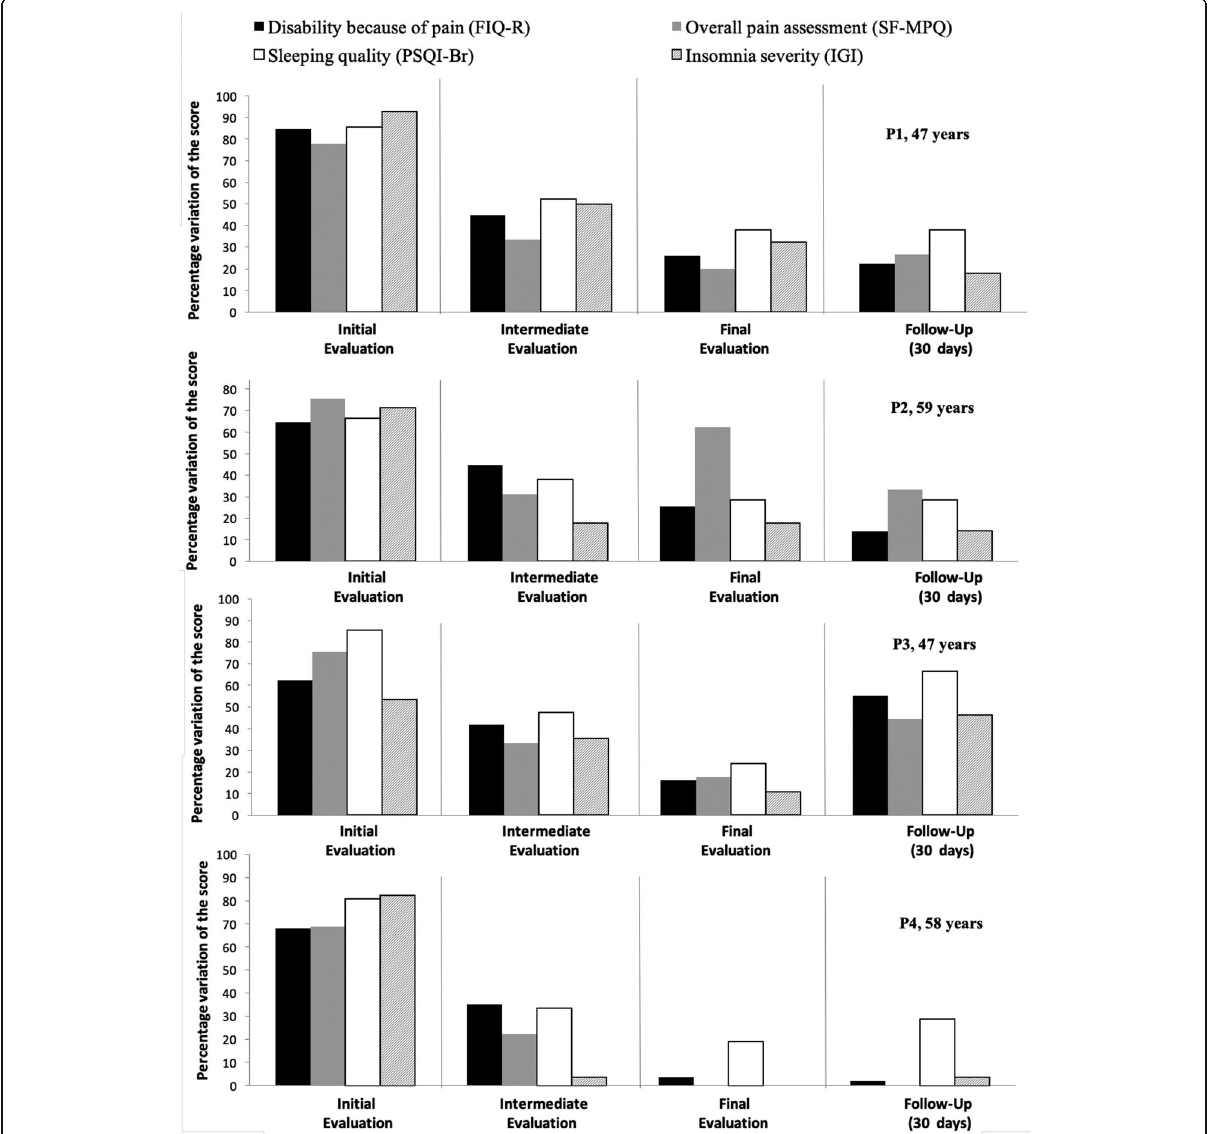
Fig. 3 Initial, intermediate, final, and follow-up assessment data expressed in percentages for each